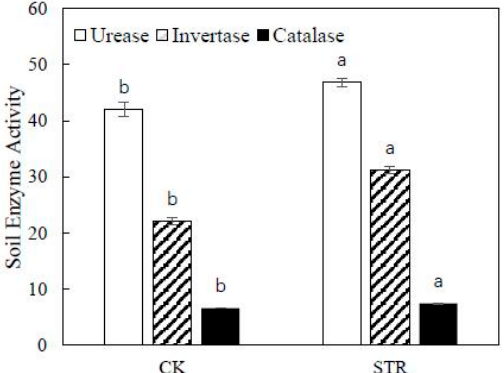
Figure 4. The soil urease (NH 4 -N mg/(g/2h/37)), invertase (glucose mg/(g/24h/37)), and catalase (H 2 O 2 mg(g/h)) activities were affected by straw incorporation (STR) and straw removal (CK). Different letters above columns for the same soil enzyme indicate a significant difference ( p < 0.05).